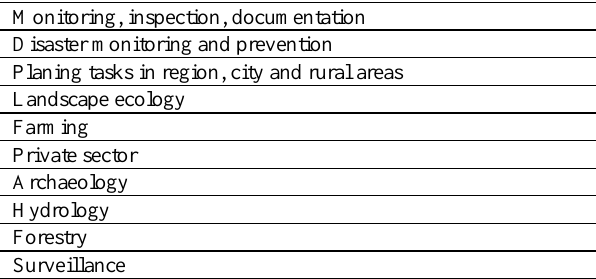
Table 1: Examples for application areas for UAVs